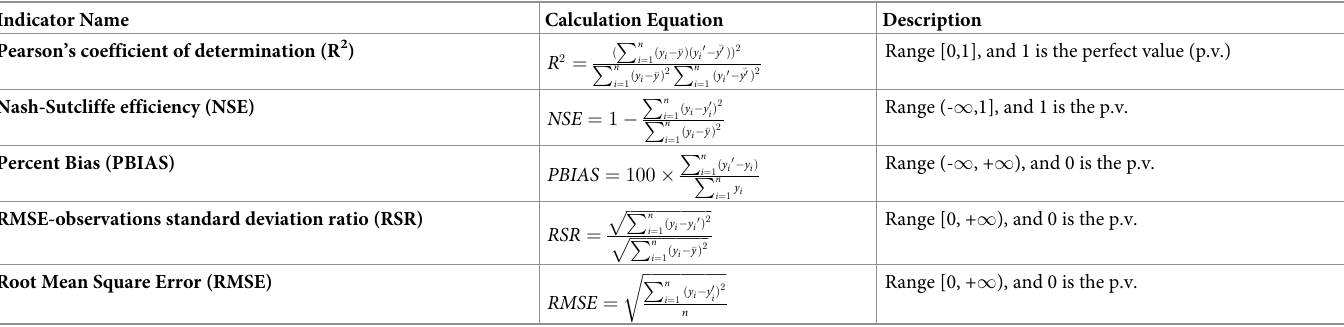
Table 2. Evaluation indicators of the model performance and their mathematic expressions†.